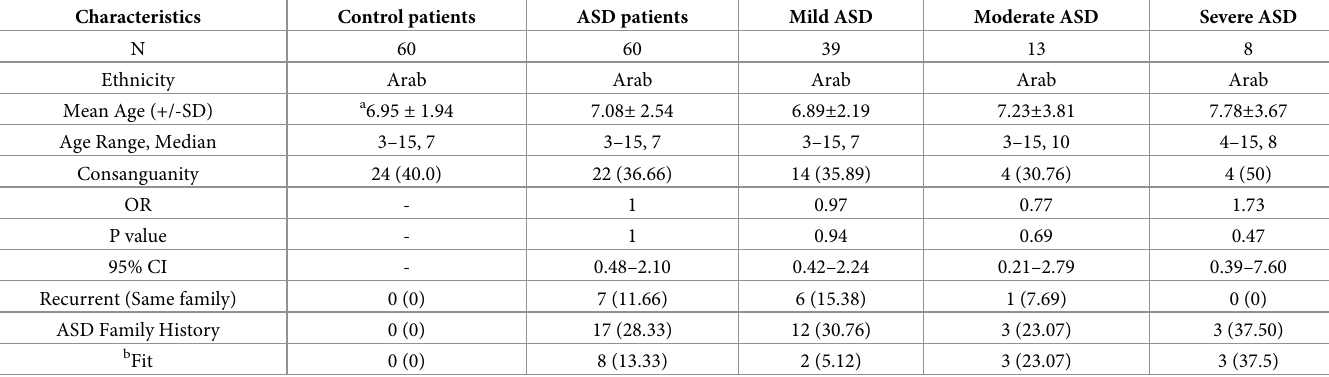
Table 1. Patient ethnicity, consanguinity, recurrence, and family history of ASD.